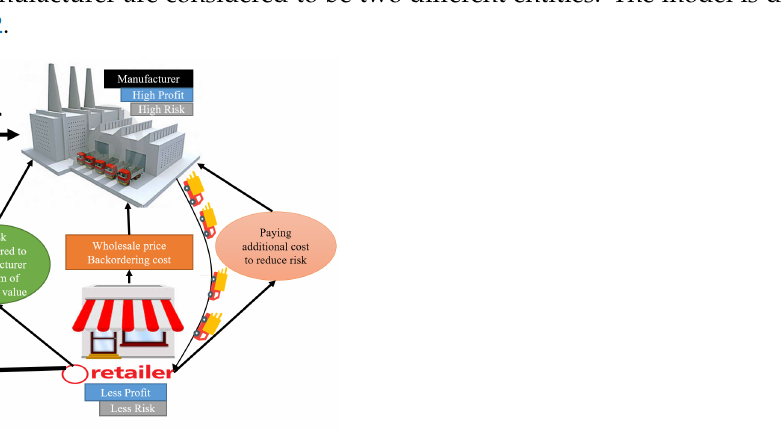
Figure 2. Transfer of risk in the supply chain. (Some parts of the image are taken from Khan et al. [22] Figure